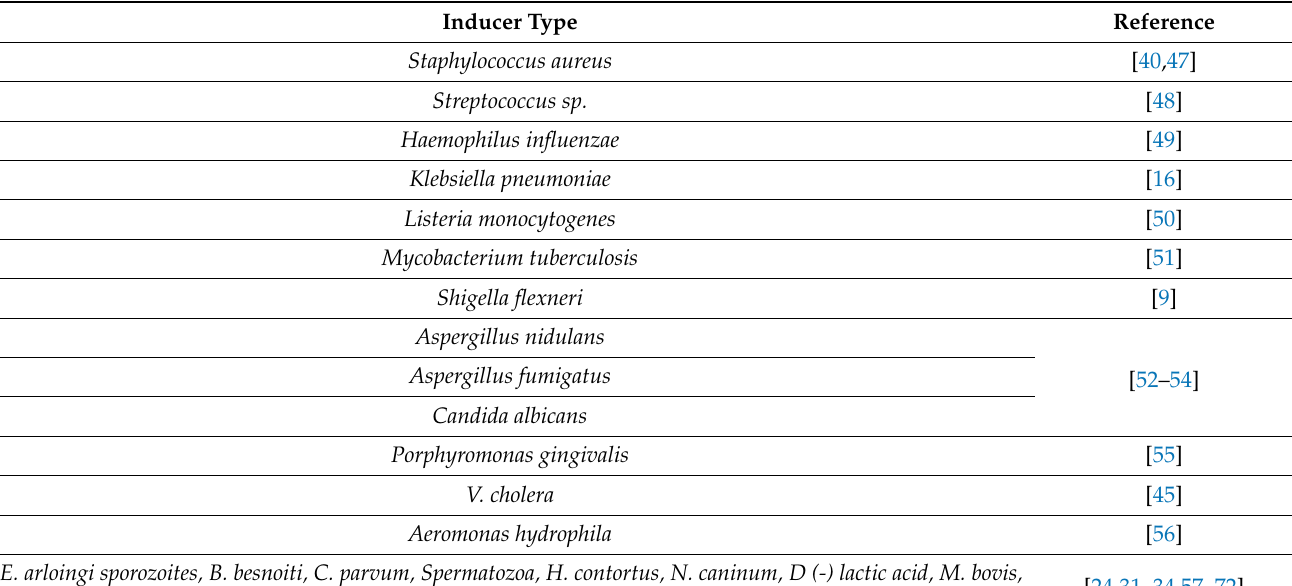
Table 2. Microbial inducers of